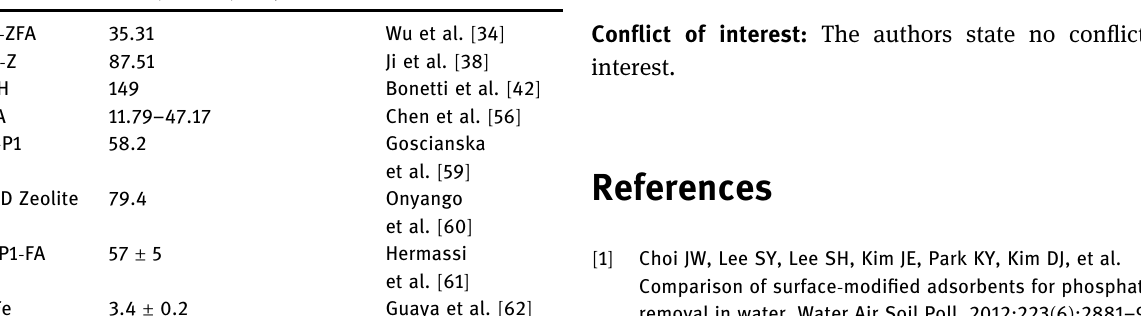
Table 6: Comparison of phosphorus adsorption capacity of various zeolite adsorbents